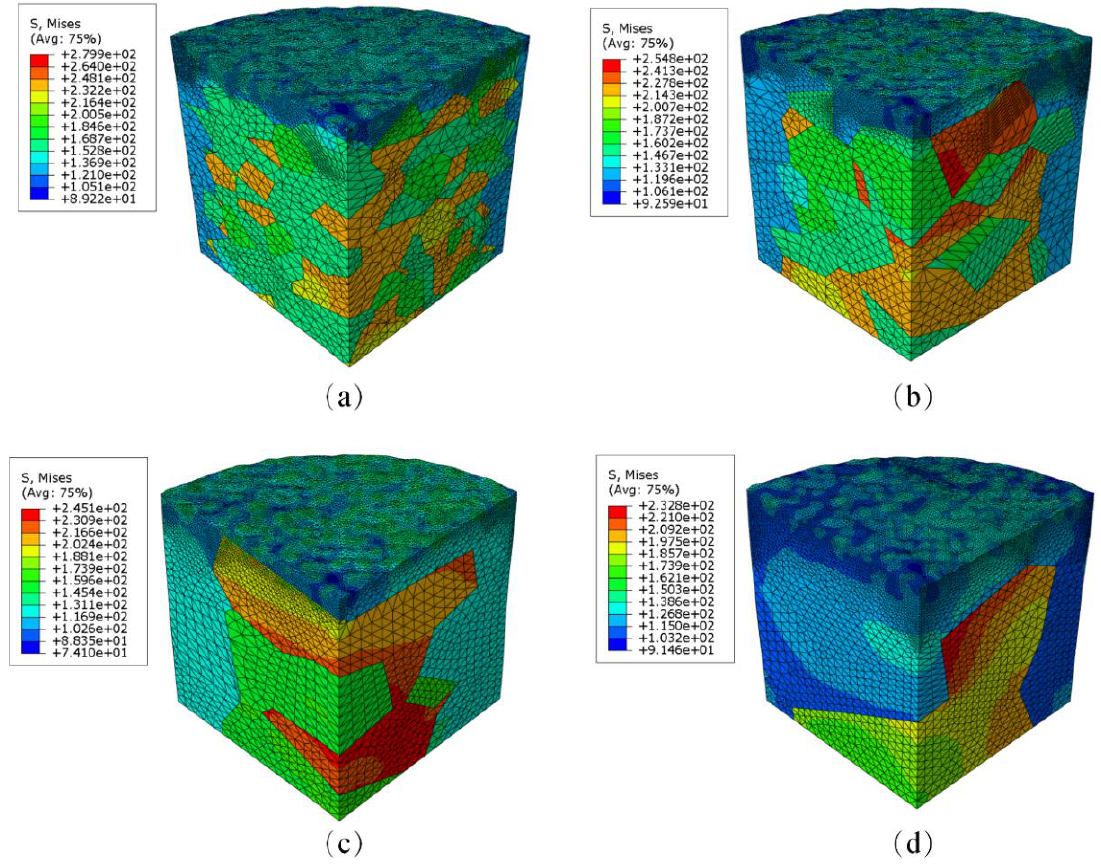
Figure 8. The equivalent stress of the deformed specimen for different grain sizes ( a ) d = 30 μm; ( b ) d = 50 μm; ( c ) d = 80 μm; and ( d ) d = 120 μm.